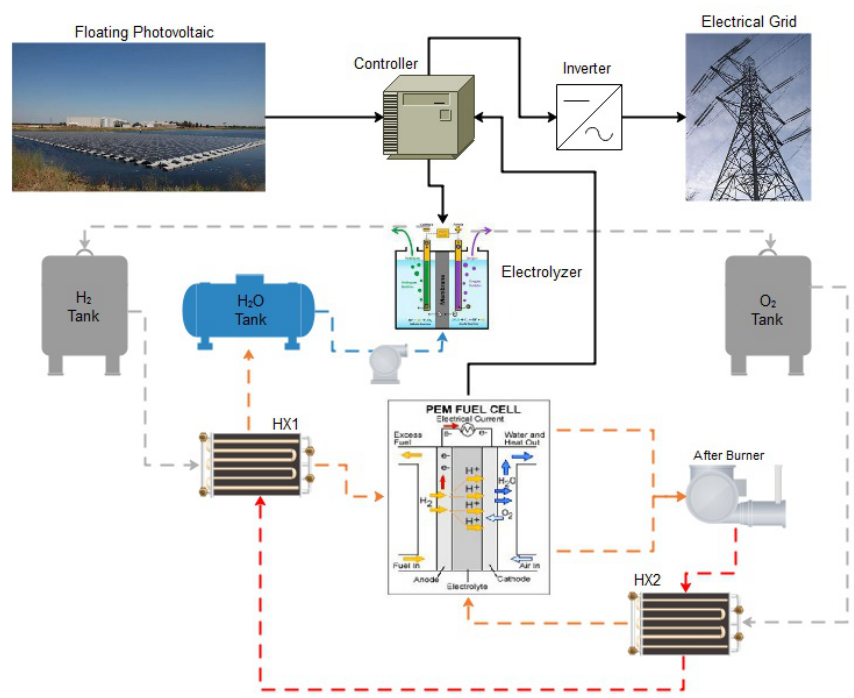
Figure 11. Schematic of the